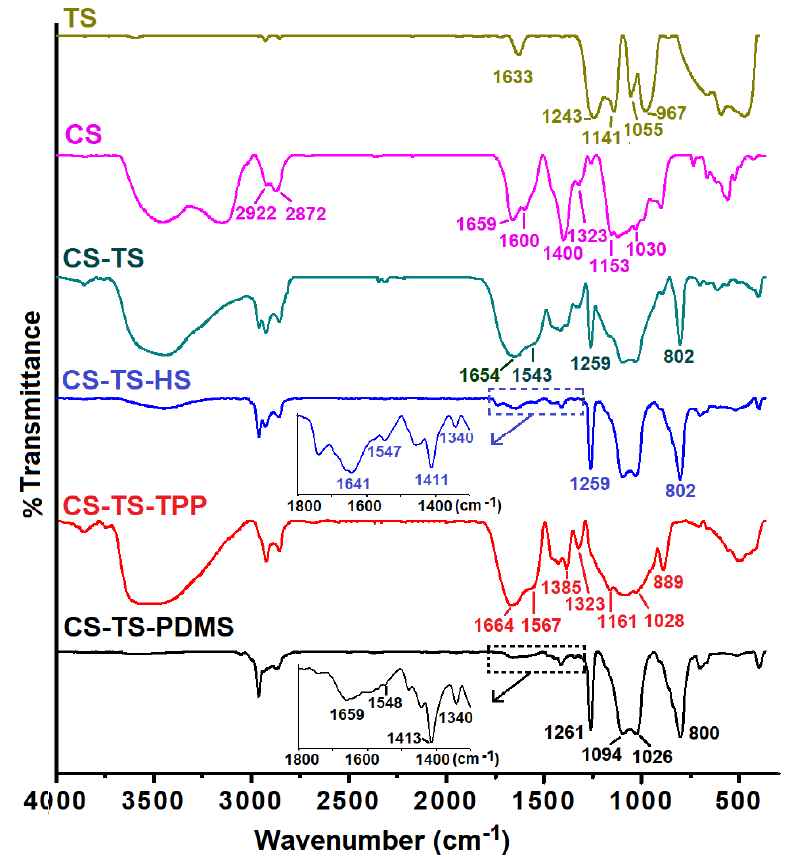
Figure 1. FTIR spectra of sulfated TiO 2 (TS), pristine chitosan (CS) and CS-TS, CS-TS-HS, CS-TS-TPP, and CS-TS-PDMS composite membranes. For CS sample the characteristic absorption bands appear in the range 4000–800 cm − 1 [22]. Thus, broad bands between 3500–3100 cm − 1 (O–H and N–H stretching vibration) are visible in the CS spectrum, while asymmetric and symmetric stretching vibrations of C–H groups are located at 2922 1600 cm − 1 (N–H in plane deformation, primary amine), 1400 cm − 1 (N–H deformation, amide II) and